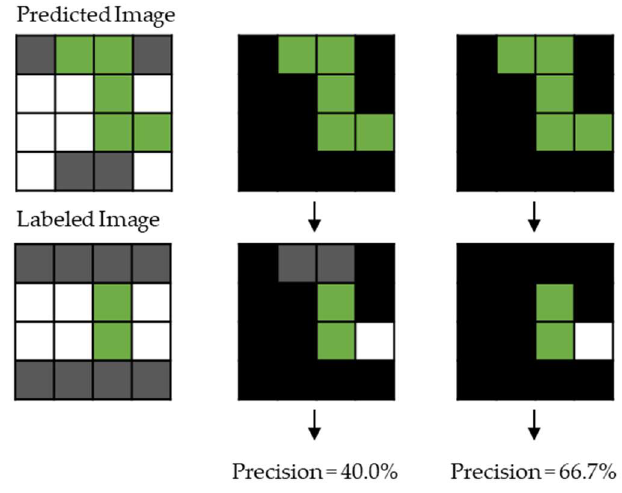
Figure 10. Rethinking assessment computation for sparse point cloud-derived images.